Question: Does the plotted quantity increase or decrease?
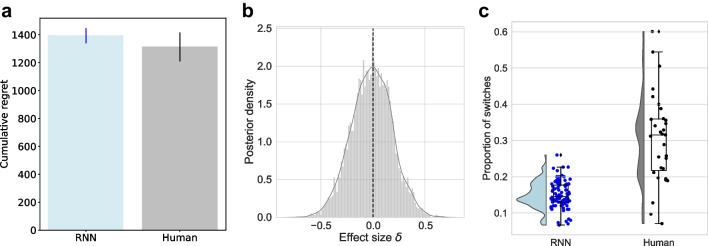
Answer: increasing